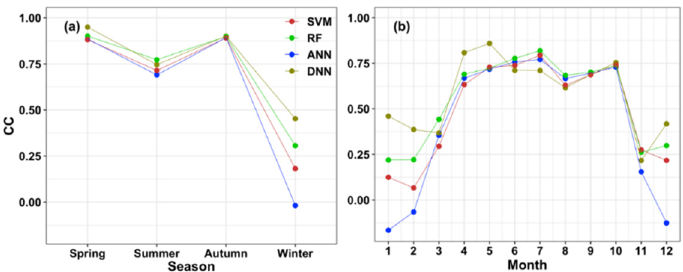
Figure 8. Comparisons of the correlation coefficients between observed vs. predicted gross primary productivity (GPP) by the artificial intelligence (AI) models, according to season ( a ) and month ( b ).